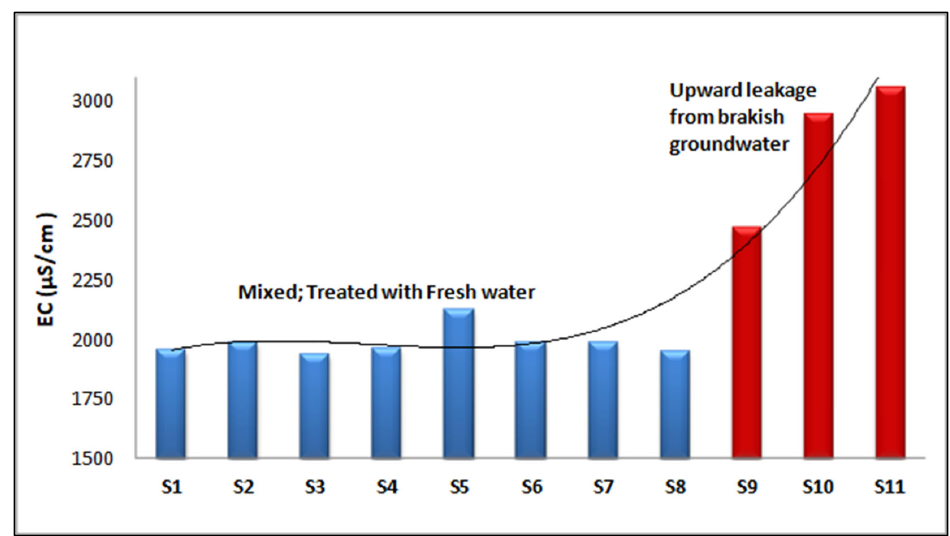
Figure 8. Upward leakage of brackish groundwater from the sandstone (Kurnub) aquifer.